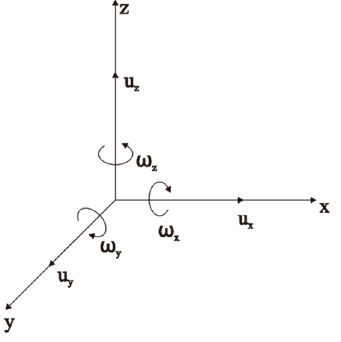
Figure 1. The translations and rotations.